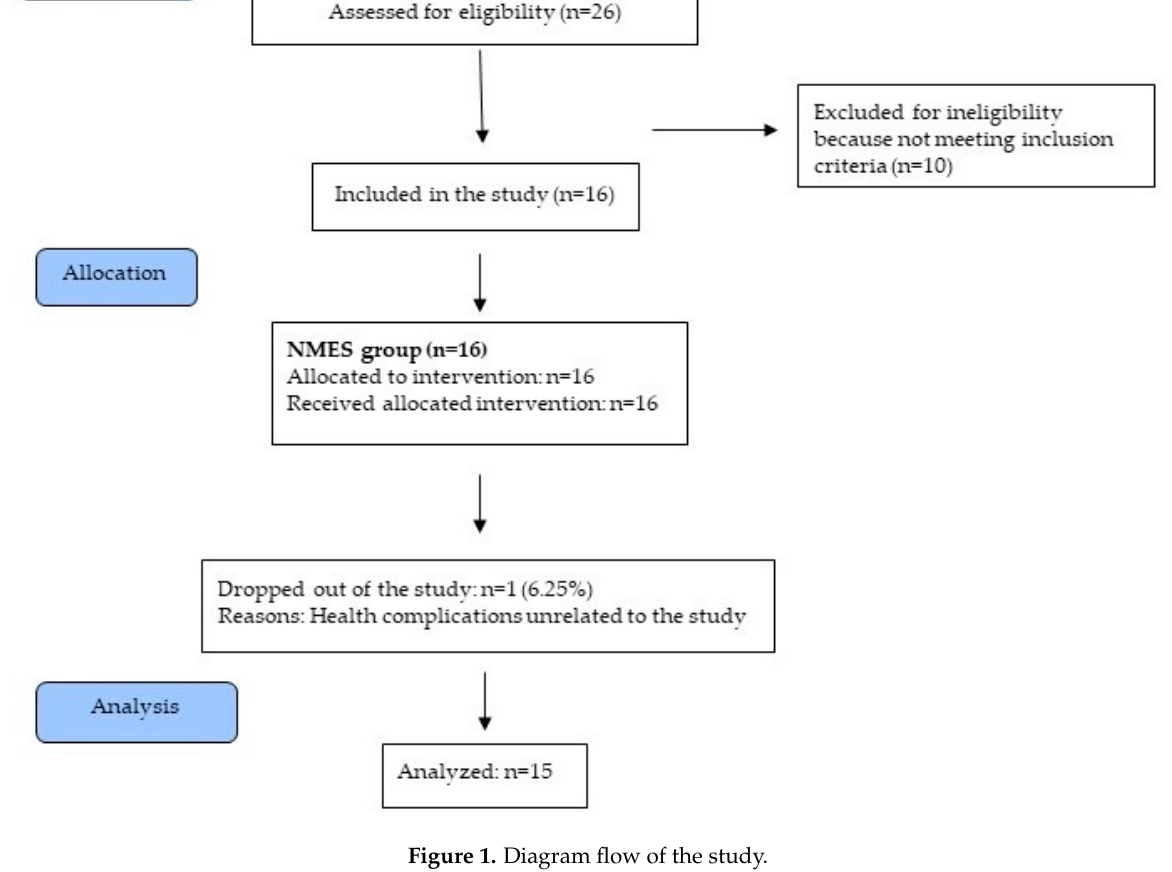
Figure 1. Diagram flow of the study.